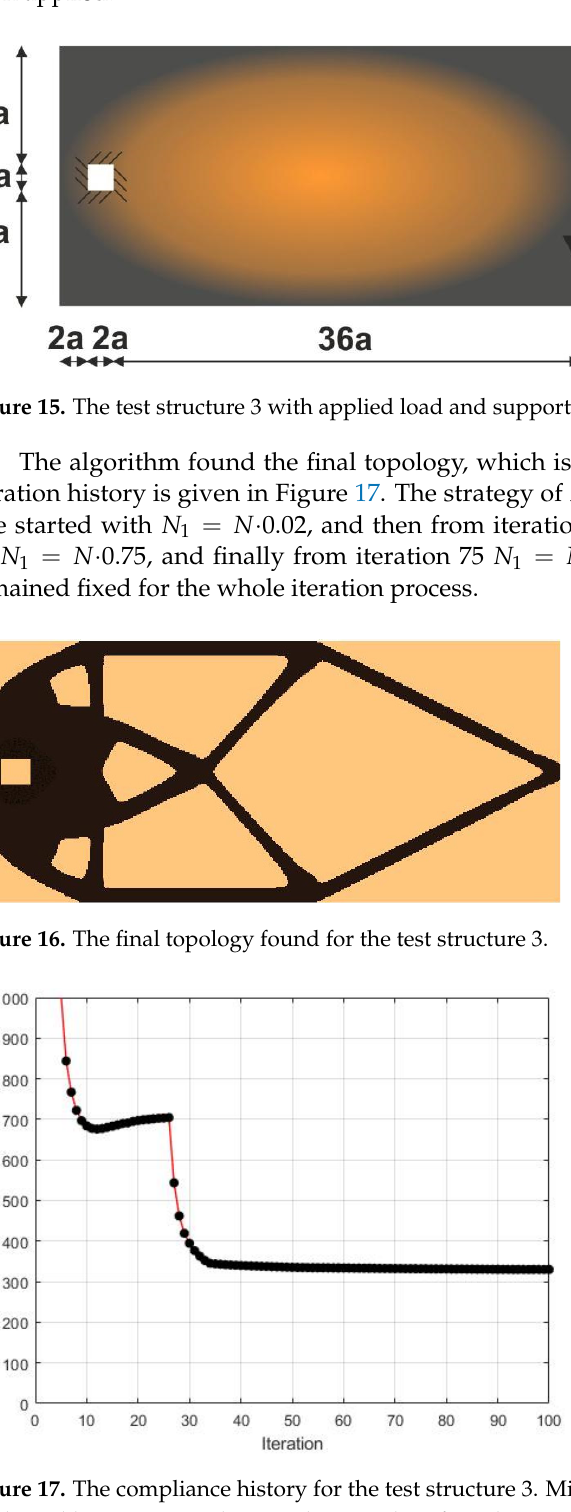
Figure 14. The compliance history for the test structure 2. Minimal value: 125.07 Nmm. Black dots on the red line represent the compliance values for subsequent iterations.